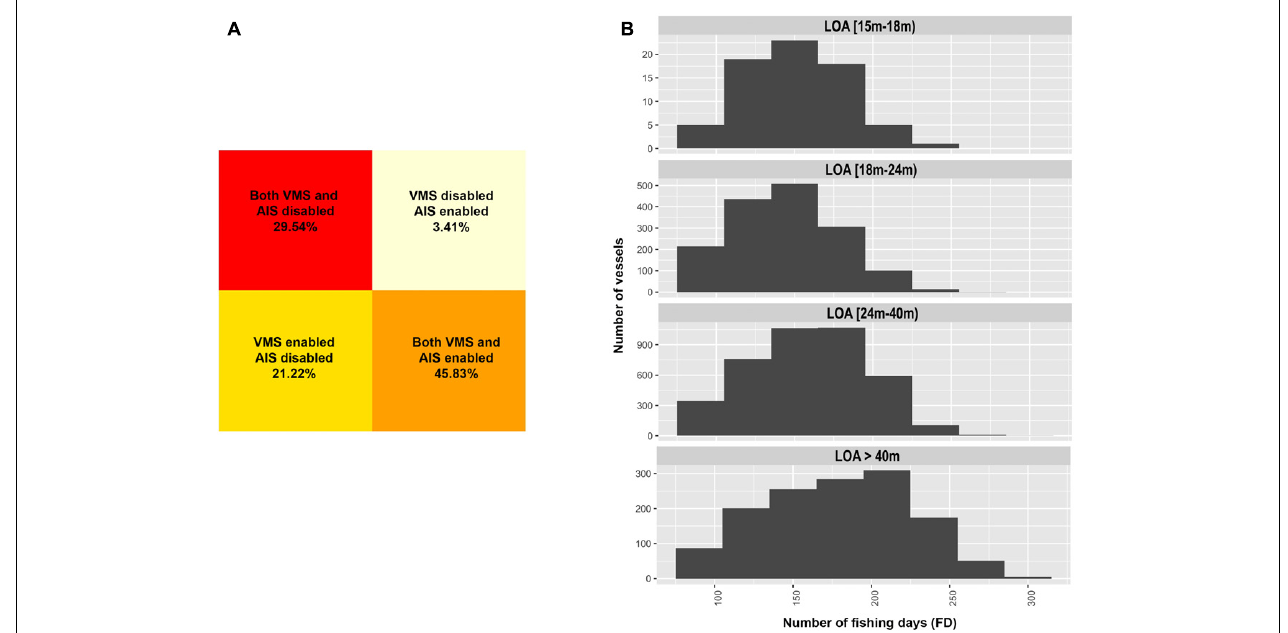
FIGURE 2 | (A) Agreement between VMS and AIS in tracking the daily activity of 195 fishing vessels equipped with both systems, during the year 2016; (B) Histograms (by length classes) of the total number of fishing days by year for the OTB over15 fleet equipped with VMS.